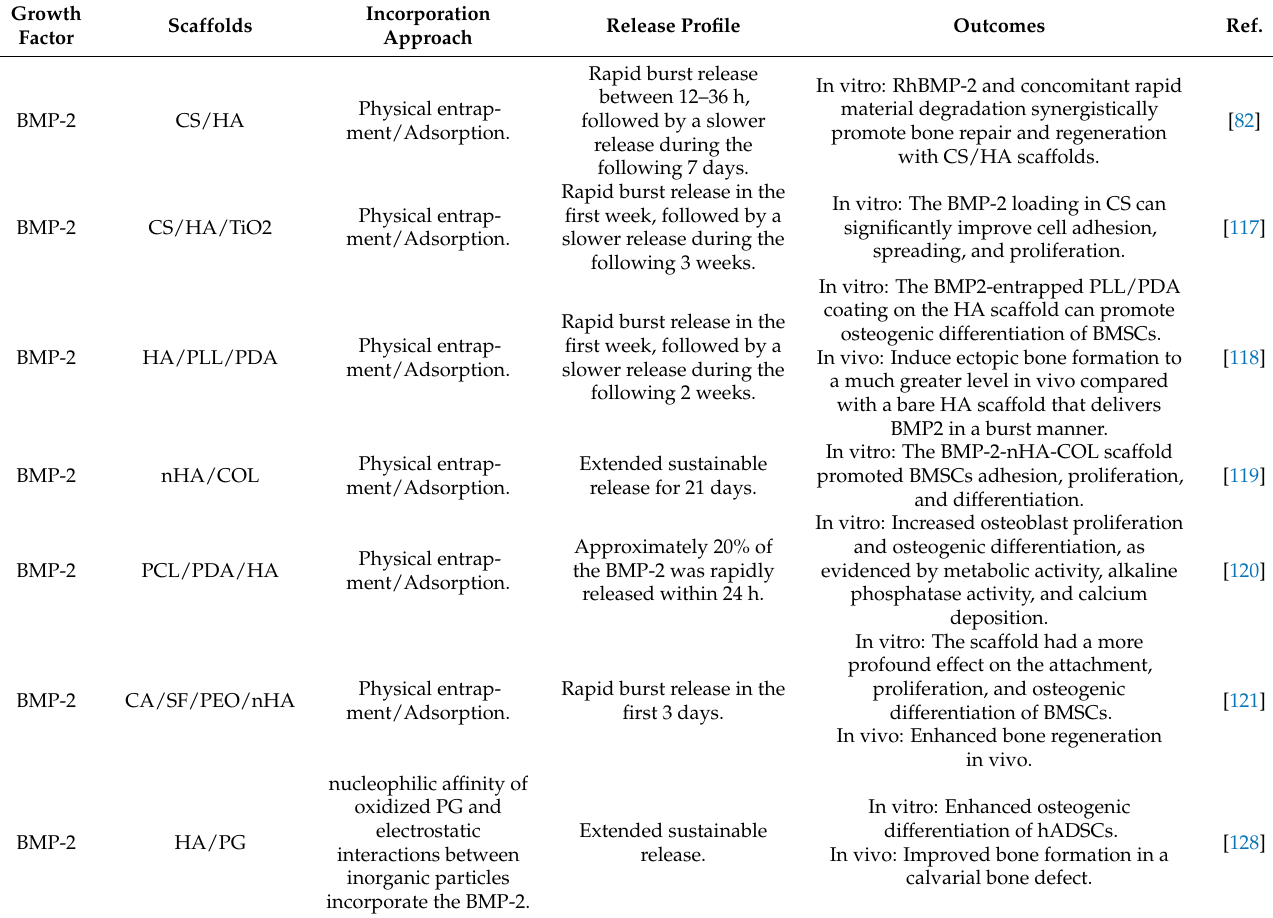
Table 3. Growth factors commonly used in tissue